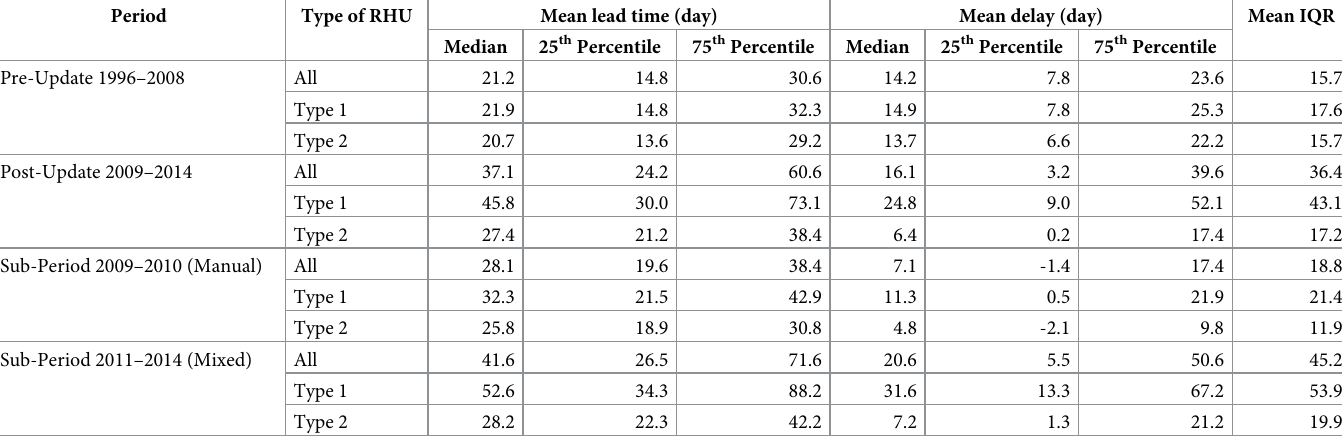
Table 2. Mean lead time, mean delay and mean IQR before and after the update. Period